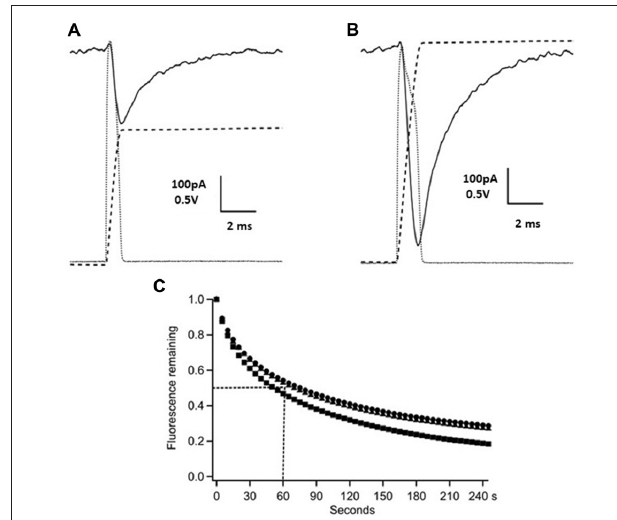
FIGURE 1 | Time-course of γ - D -glutamyl-glycine ( γ - D GG) concentration during and following photorelease. Panels (A,B) show photodiode records of the flash (dotted gray traces, scale bar 0.5 V) and their integrals over the pulse representing the time-course of the γ - D GG concentration (dashed traces), and the whole cell current generated by photolysis of MNI-caged γ - D GG in a Purkinje neuron at − 60 mV (black traces, scale bar 100 pA). Panel (A) shows the response to a low intensity flash as used in synaptic experiments, producing 14% conversion to release γ - D GG and proton concentrations of 0.65 mM. Panel (B) shows the response to a strong flash releasing 1.3 mM γ - D GG and protons. The bath concentration of MNI-caged γ - D GG was 4.6 mM in (A,B) . (C) Following wide-field photolysis of NPE-HPTS the time-course of diffusional loss of HPTS fluorescence was monitored from a region defined by an aperture in a conjugate image plane corresponding to 10 µ m in the slice. HPTS and amino acids have similar diffusion coefficients in extracellular space. A single flash released HPTS from 100 µ M NPE-HPTS equilibrated in the slice. Fluorescence of photoreleased HPTS (em 525/50 nm) from the 10 µ m spot was measured every 5 s thereafter, corrected for background counts and normalized to the maximum fluorescence immediately after the flash. The data are from three trials, the dotted lines show the mean half-time for the fluorescence decline, estimated as 60 s; the time-course is expected to be similar for photoreleased γ - D